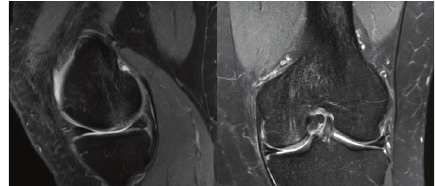
Figure 3: Sagittal and coronal T2-weighted MRI of left knee joint illustrating well repaired previous defective area with almost isointense,firmlyintegratedneocartilageformationatsimilarheight to the surrounding cartilage without significant BME and healthy appearing subchondral bone at dorsomedial femoral condyle (6 months